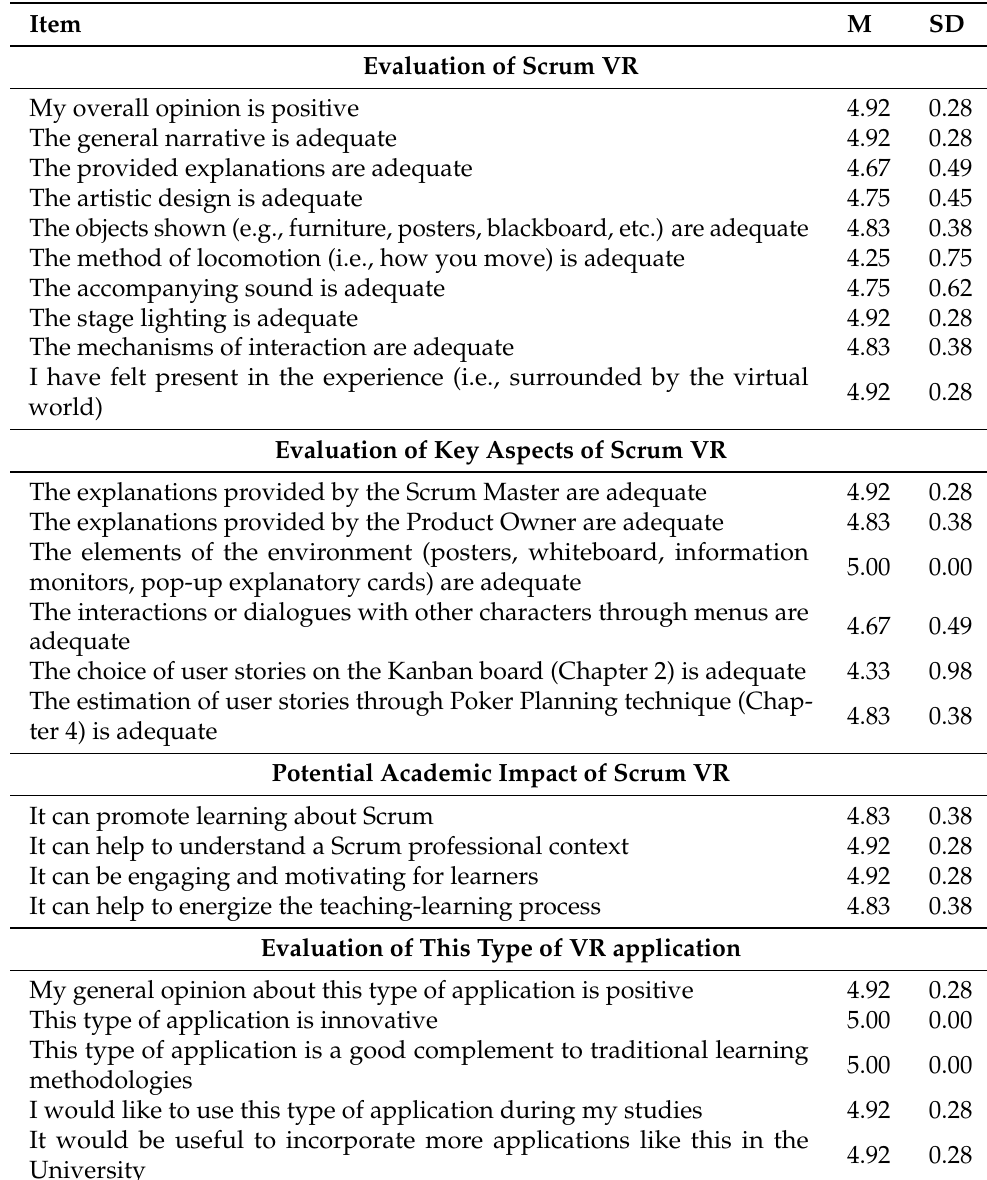
Table 2. Quantitative results: Student’s